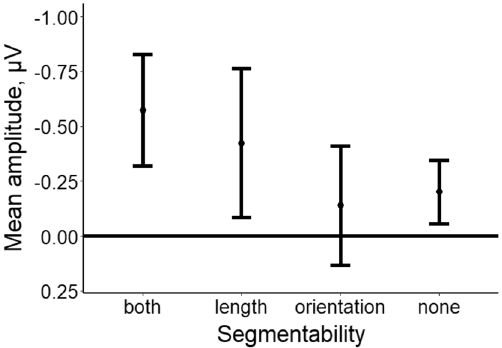
Figure 3. The mean amplitude of the difference wave within a 150–266 ms time window as a function of segmentability. Error bars denote 95% confidence intervals, with between-subject variance removed in accordance with the Cousineau method 47